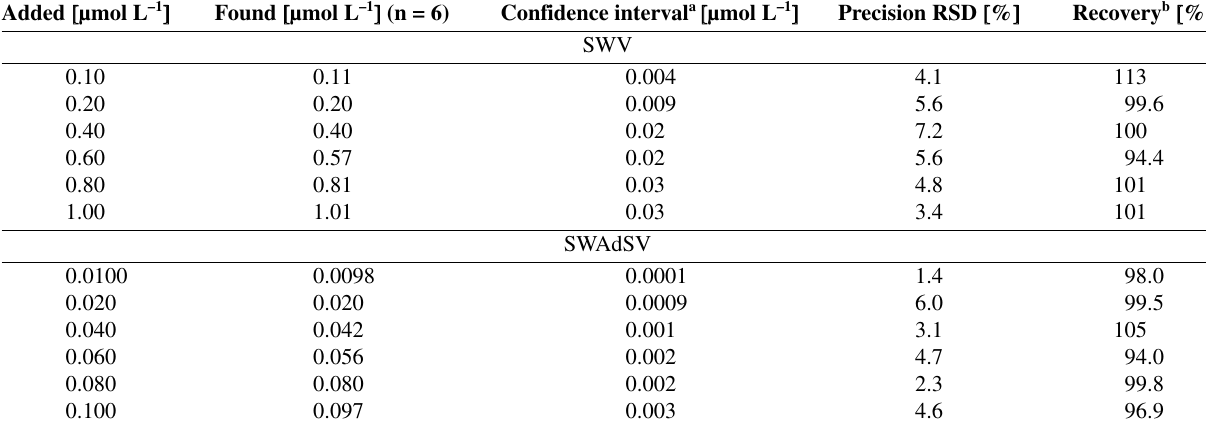
Table 1. Recovery and precision of the aclonifen peak currents at various aclonifen concentrations. Added [[ μmol L –1